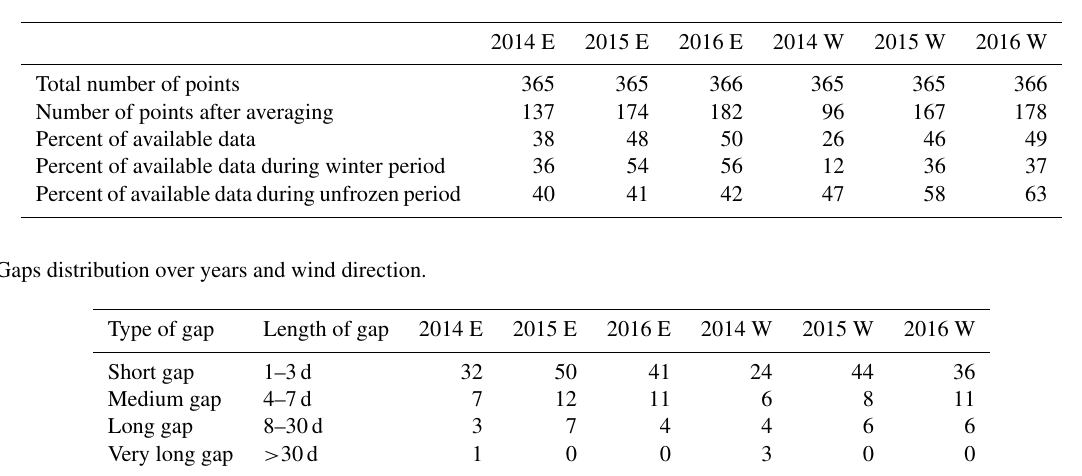
Table 2. The size of available daily datasets after gap-filling by daily averaging for each year and wind sector.